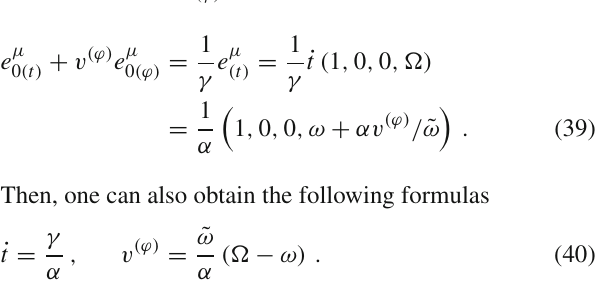
Fig. 5 This density contour plot shows the g -factor measured by a face-on observer ( λ o =0), depicted on the ( a , | (cid:2) | ) plane. The emission is assumed to be from the accreting particles on the ISCO. The solid black and the dashed gray curves represent the contours of constant ISCO for Kerr-like and the Kerr black holes, respectively. On the ISCO, the constant- | y c | contoursareshownbythedashedredcurves.Themagenta curve shows the critical value given by Eq. (16). The blue solid (purple dashed) curve indicates the parameter space where ISCO is located on the naked singularity